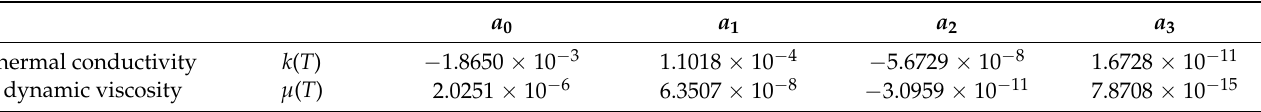
Table 2. Coefficients of polynomial equation k ( T ), µ ( T ) = a 0 + a 1 × T + a 2 × T 2 + a 3 × T 3 for the air temperature range 173–373 K.